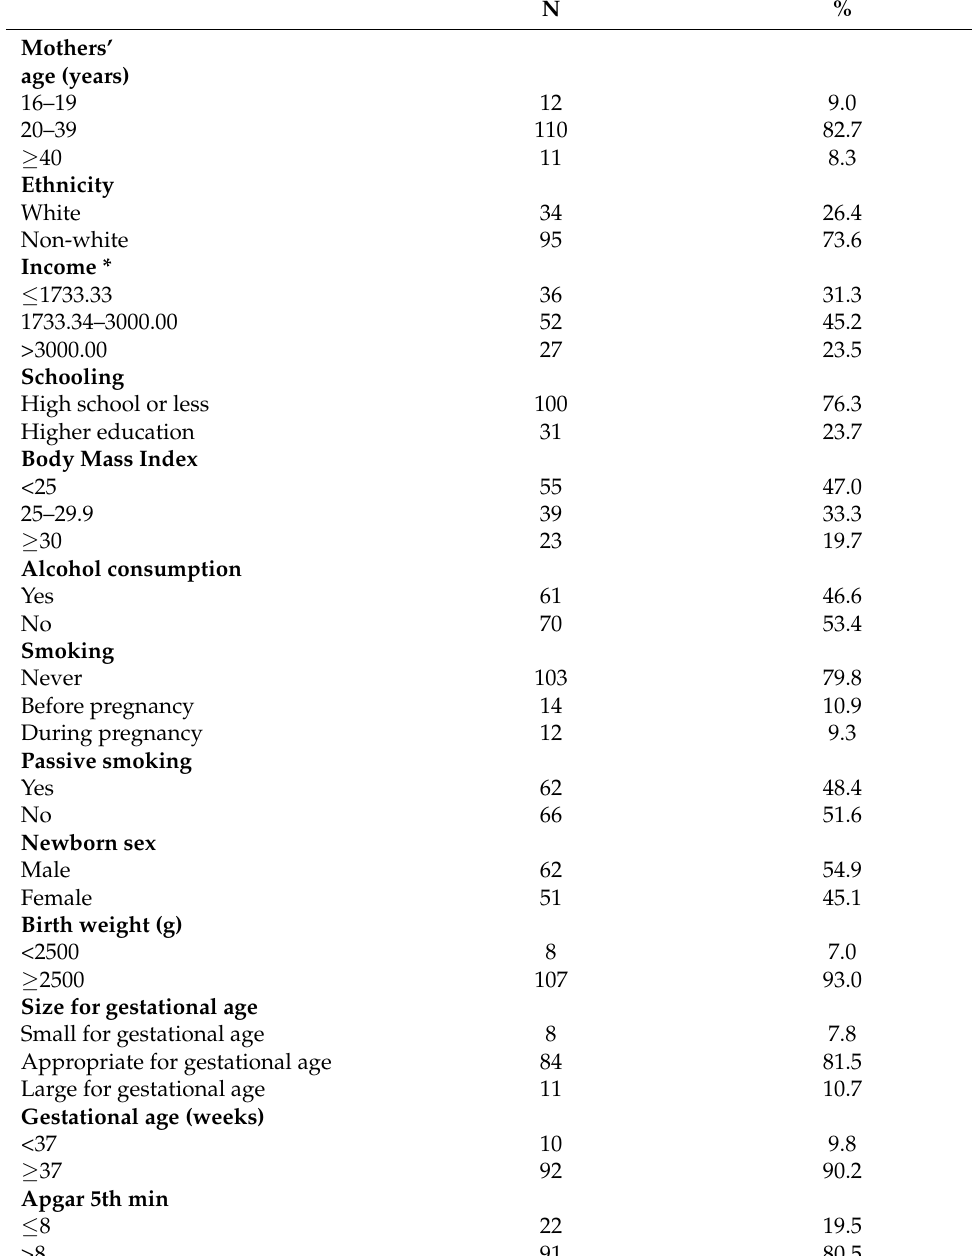
Table 1. Main characteristics of the studied